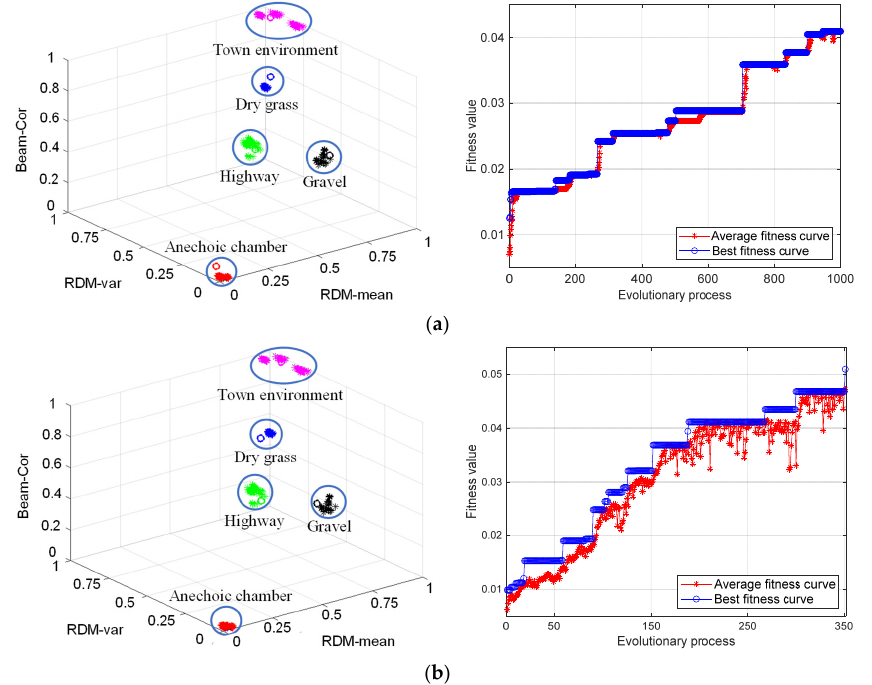
Figure 8. Clustering results of SGA ( a ) and chaotic SGA ( b ) in different scenarios. The data under five different experimental scenarios are selected, the population size is set to 20, the maximum number of iterations is set to 1000, and the termination condition of the minimum criterion function value is 20. In the figure on the left, the star-shaped points are the data sets, and the hollow circles are the cluster centers of the corresponding data. Note. The variables represented by the axis in the figure are dimensionless.